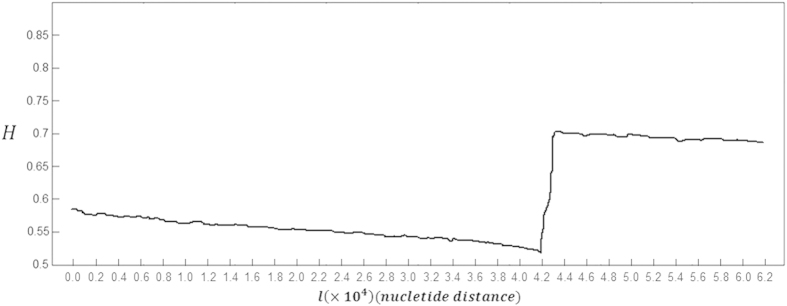
Hurst exponent plot for the real damaged DNA walk and solution of Equation (13) (after l = 4.2).